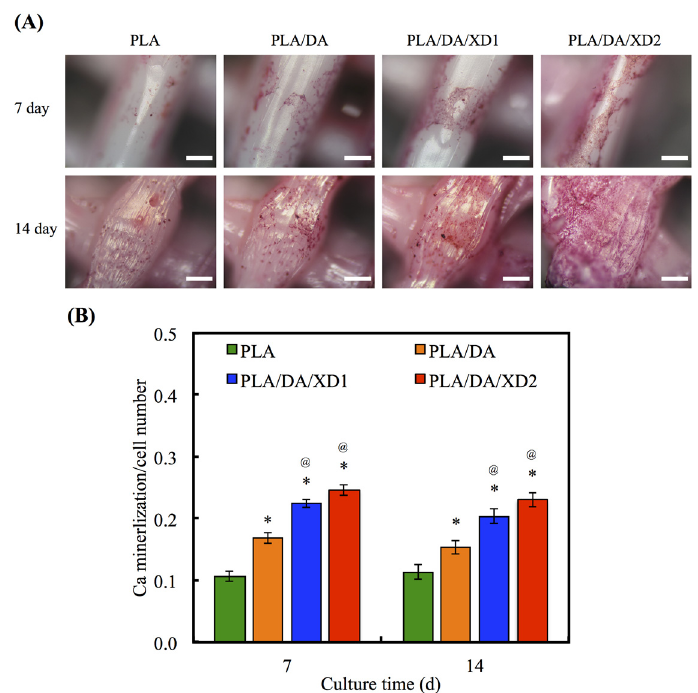
Figure 10. ( A ) Alizarin Red S staining and ( B ) quantification of calcium mineral deposits of hBMSCs cultured on various scaffolds for 7 and 14 days. The values shown are means ± standard errors for all the assays. “*” indicates a significant difference ( p < 0.05) compared to PLA; “@” indicates a significant difference ( p < 0.05) compared to PLA/DA.